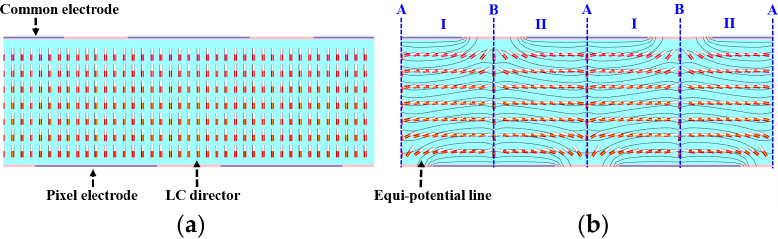
Figure 1. The device structure of a PVA cell with LC director configurations in the ( a ) off and ( b ) on states.